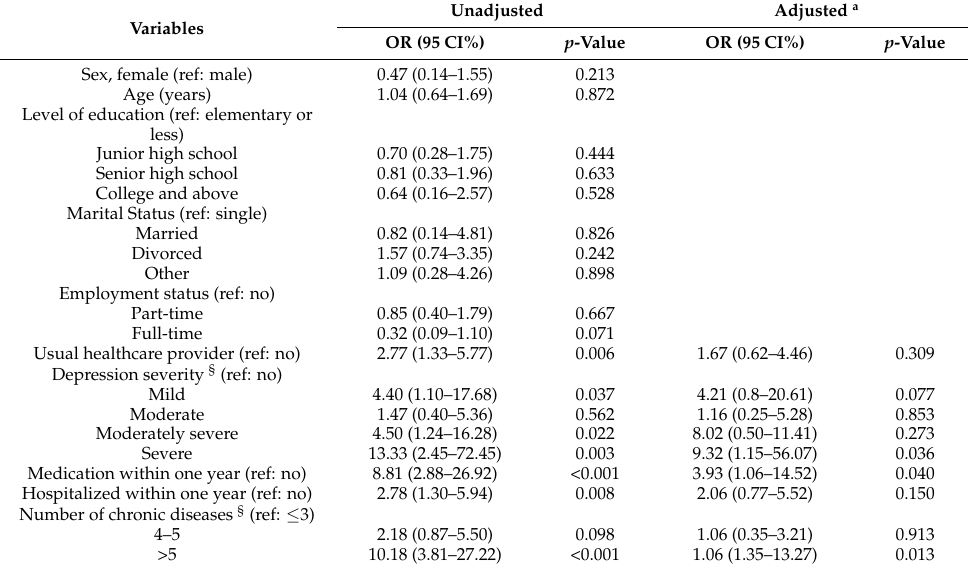
Table 4. Logistic regression analysis of high level of free hospital outpatient visits ( n =